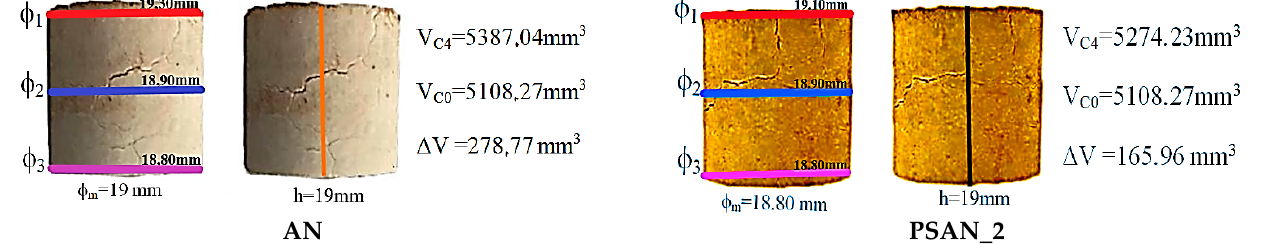
Figure 5. Technological process of PSAN cylindrical formulations.